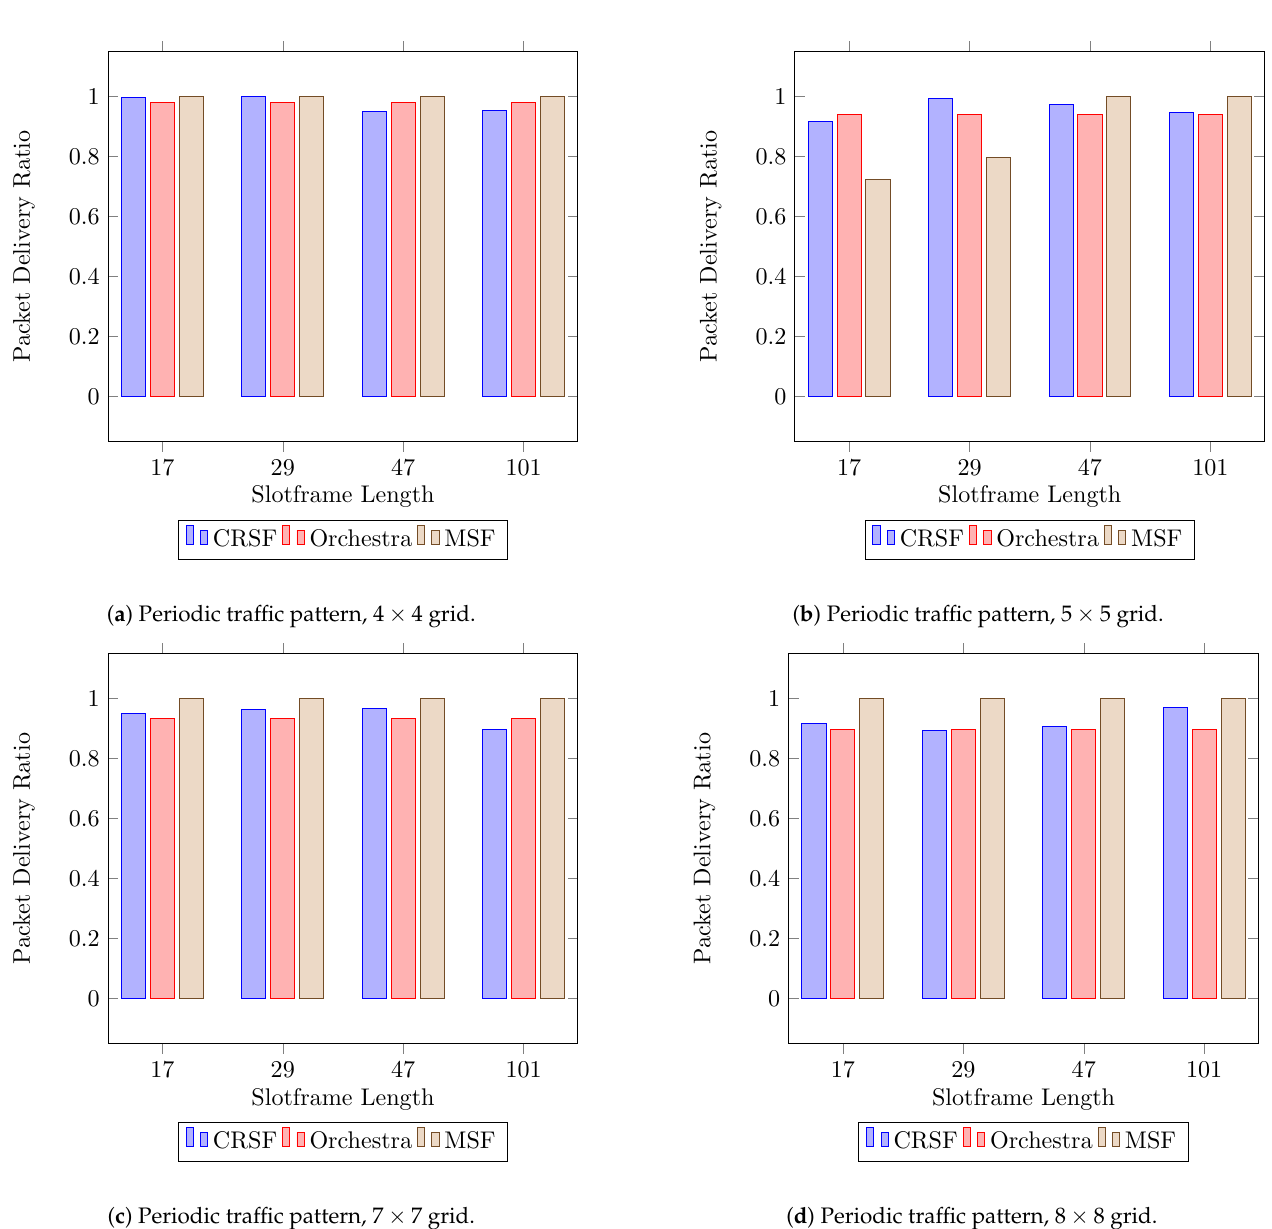
Figure 5. Average PDR performance using a periodic traffic pattern. Higher is better. The high rate calls of the CRSF to allow quick dynamic adaptations in bandwidth requirements present an impact on latency performance. Future research directions on 6TISCH SFs could focus on the trade-offs between the rate at which different SFs are called and the impact on KPIs such as latency and the